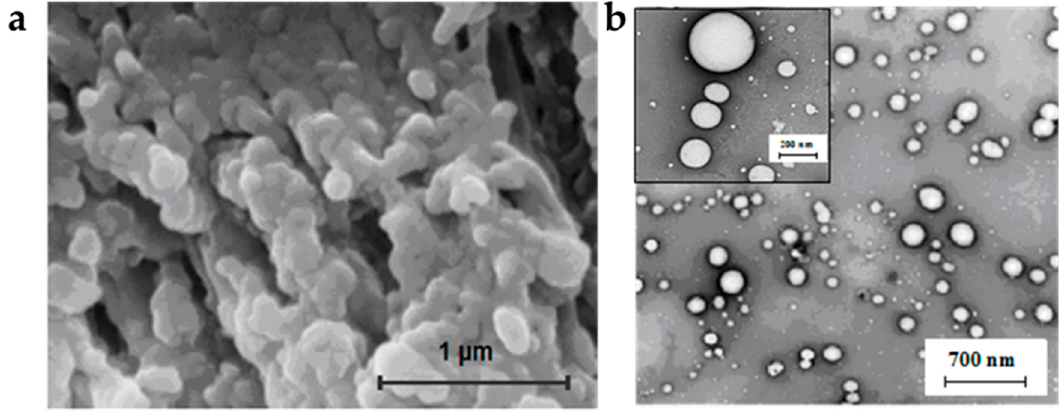
Figure 9. Electron microscopy pictures of GLN dispersion [4]: ( a ) SEM micrograph; ( b ) TEM micrograph. Copyright Clearance Center’s RightsLink® service.